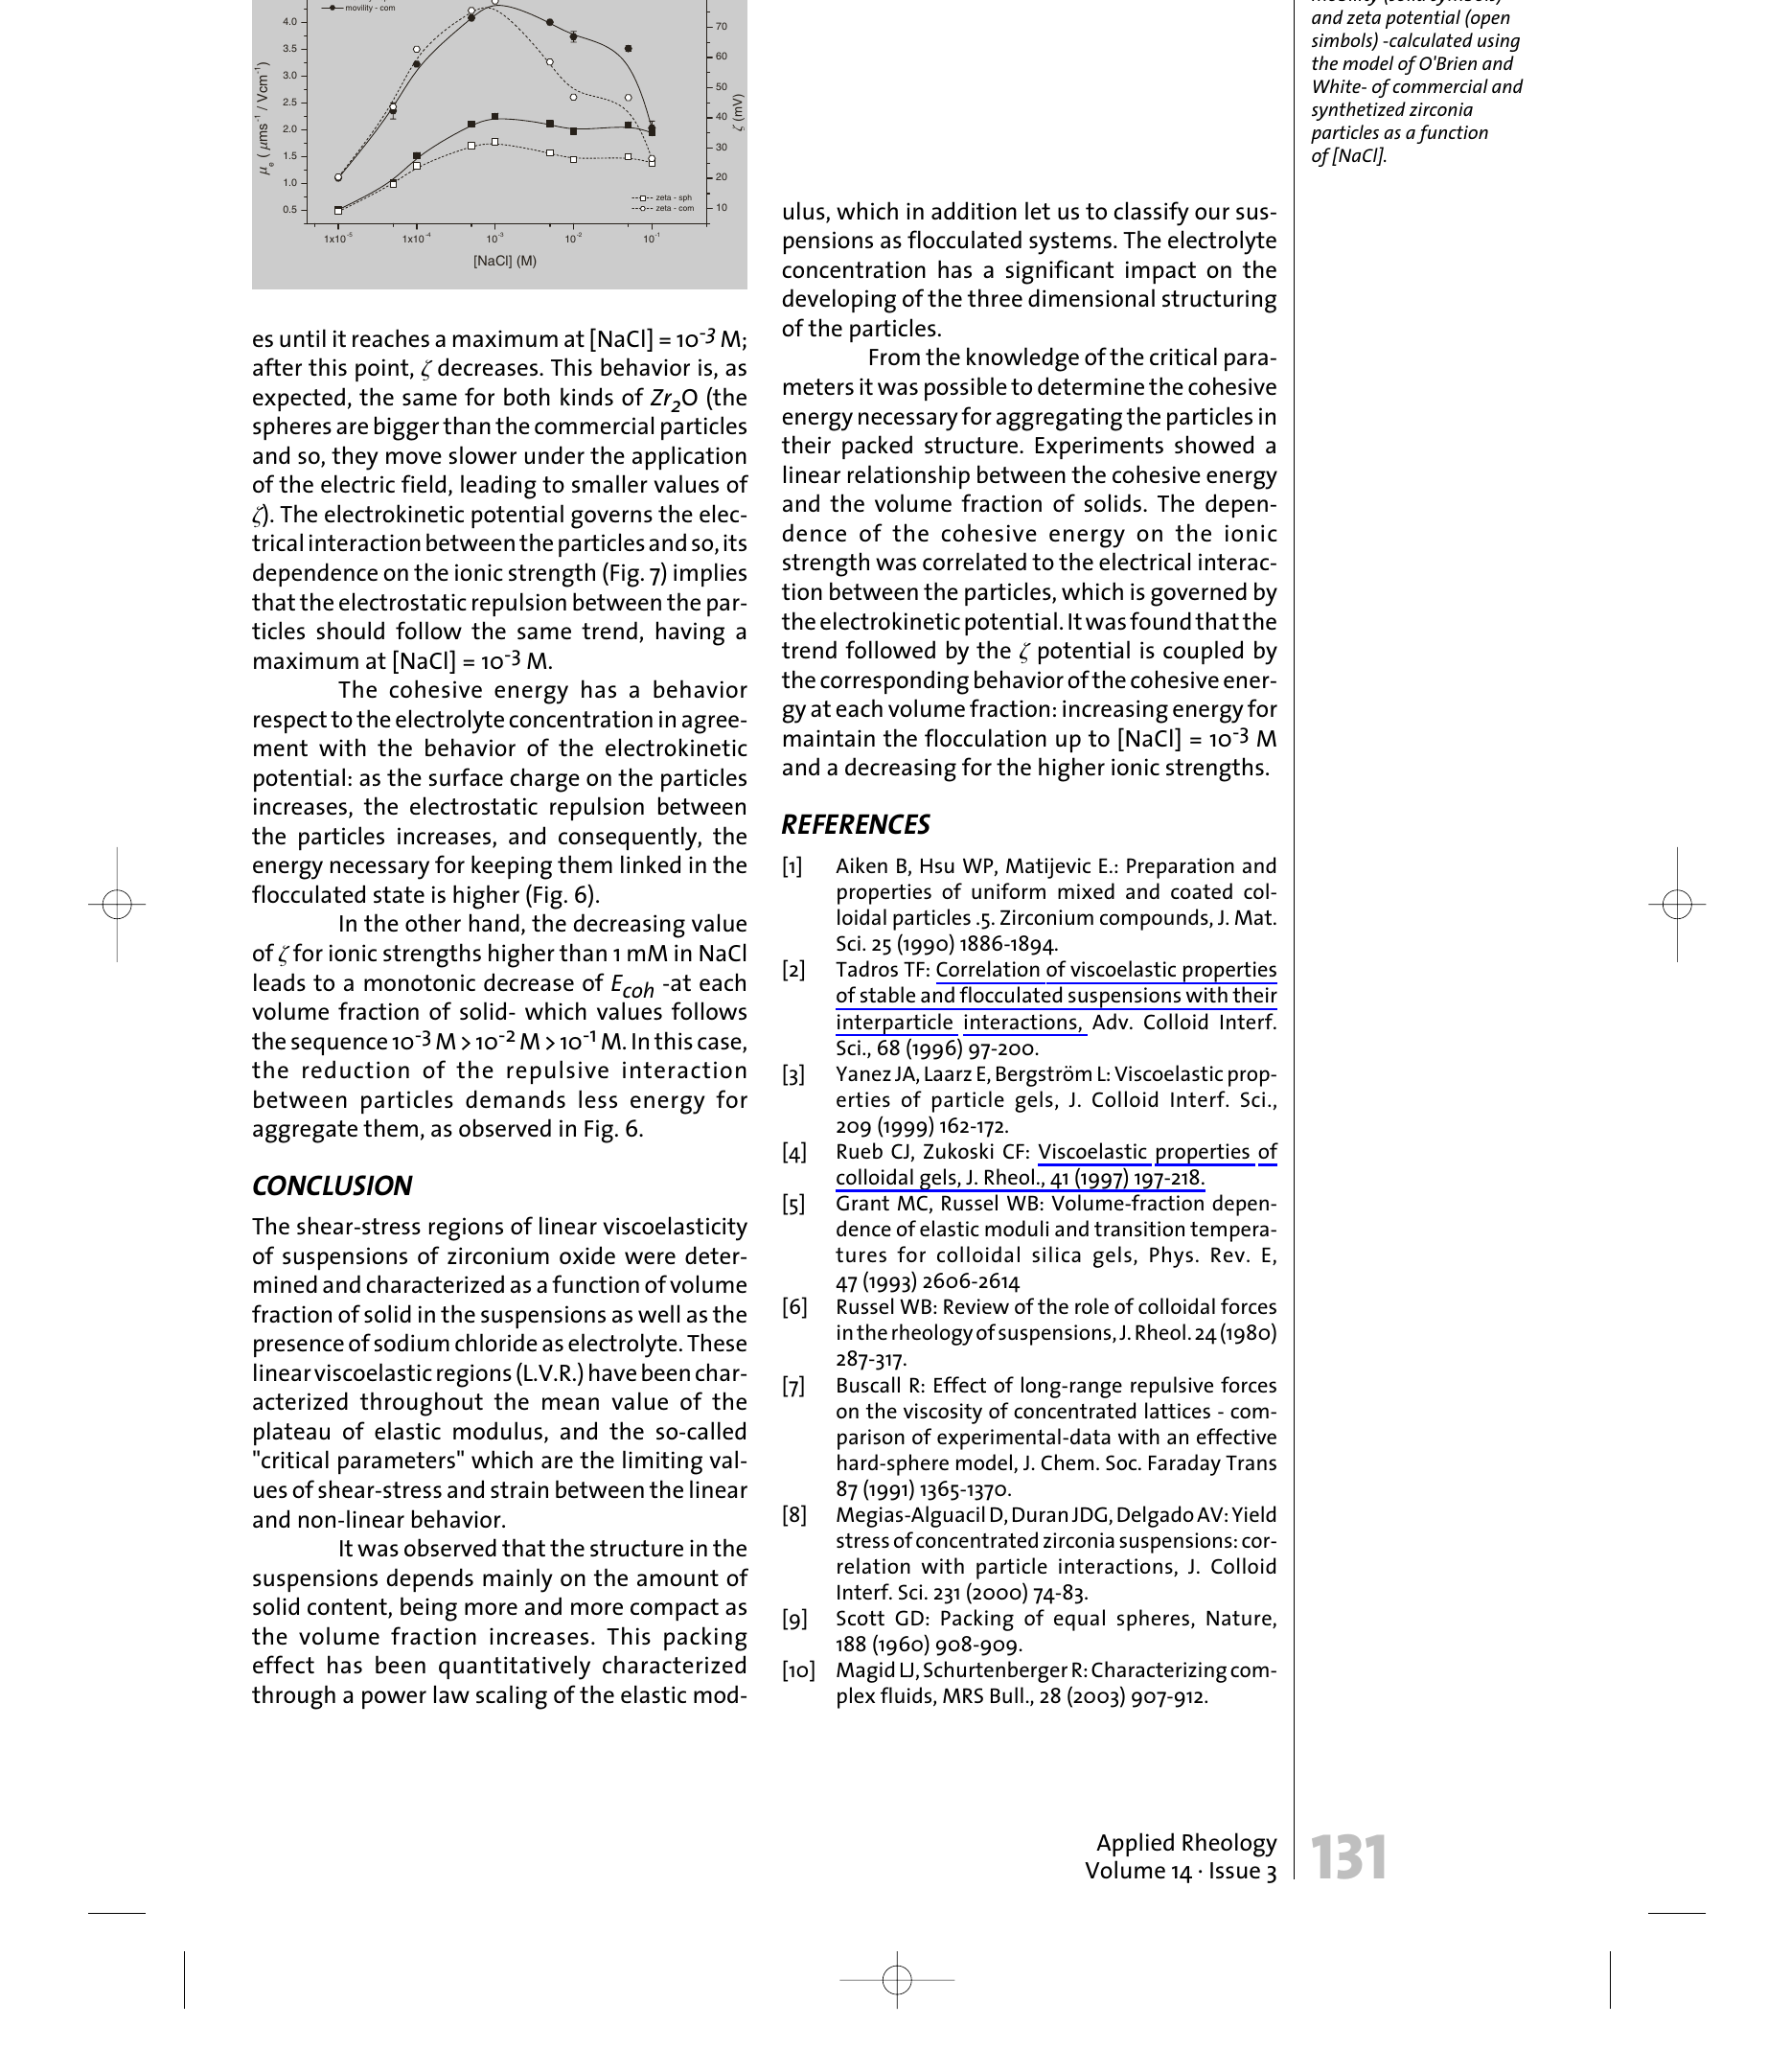
Figure 7: Electrophoretic mobility (solid symbols) and zeta potential (open simbols) -calculated using the model of O'Brien and White- of commercial and synthetized zirconia particles as a function of